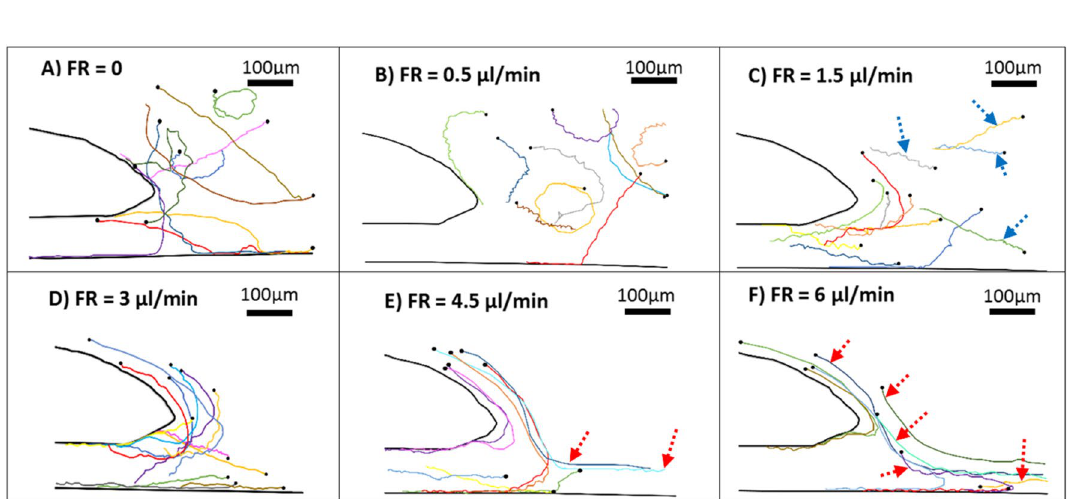
Figure 5. Motile sperm tracking history starting from the black circle. ( A ) Injected flow rate = 0, ( B ) Injected flow rate = 0.5 μl/min, ( C ) Injected flow rate = 1.5 μl/min; the blue arrows indicate the motile sperm which were able to resist the injected flow rate to swim inside the main channel rather than the rheotaxis zone, ( D ) Injected flow rate = 3 μl/min, ( E ) Injected flow rate = 4.5 μl/min, ( F ) Injected flow rate = 6 μl/min, The red arrows indicate the sperm cells reoriented against flow direction which were not able to resist the flow and were washed along the flow direction. Obtained using ImageJ 45